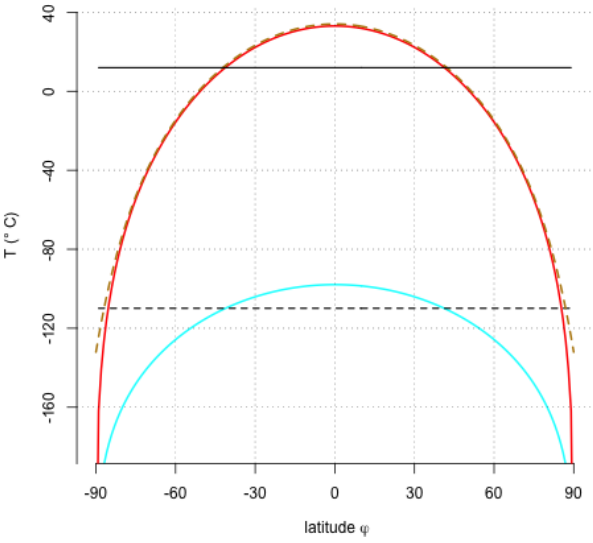
Figure 3. Latitudinal temperatures of the EBM with zero heat ca- pacity (Eq. 7) shown in cyan (its mean shown as a dashed line), the global approach (Eq. 3) shown as a solid black line, and the zonal and time averaging (Eq. 12) shown in red. Please note that both curves are exactly 0 K = − 273 . 15 ◦ C at the poles, but those values were not shown for graphical reasons. The dashed brownish curve shows the numerical solution by taking the zonal mean of Eq.